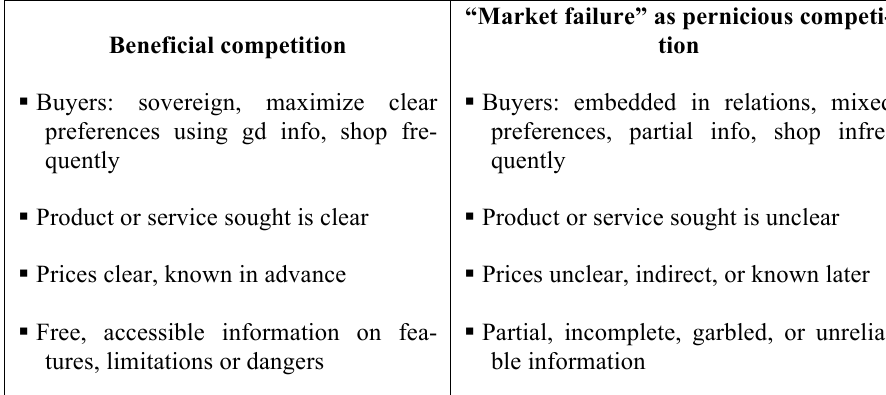
Quality focused on populations-based out-